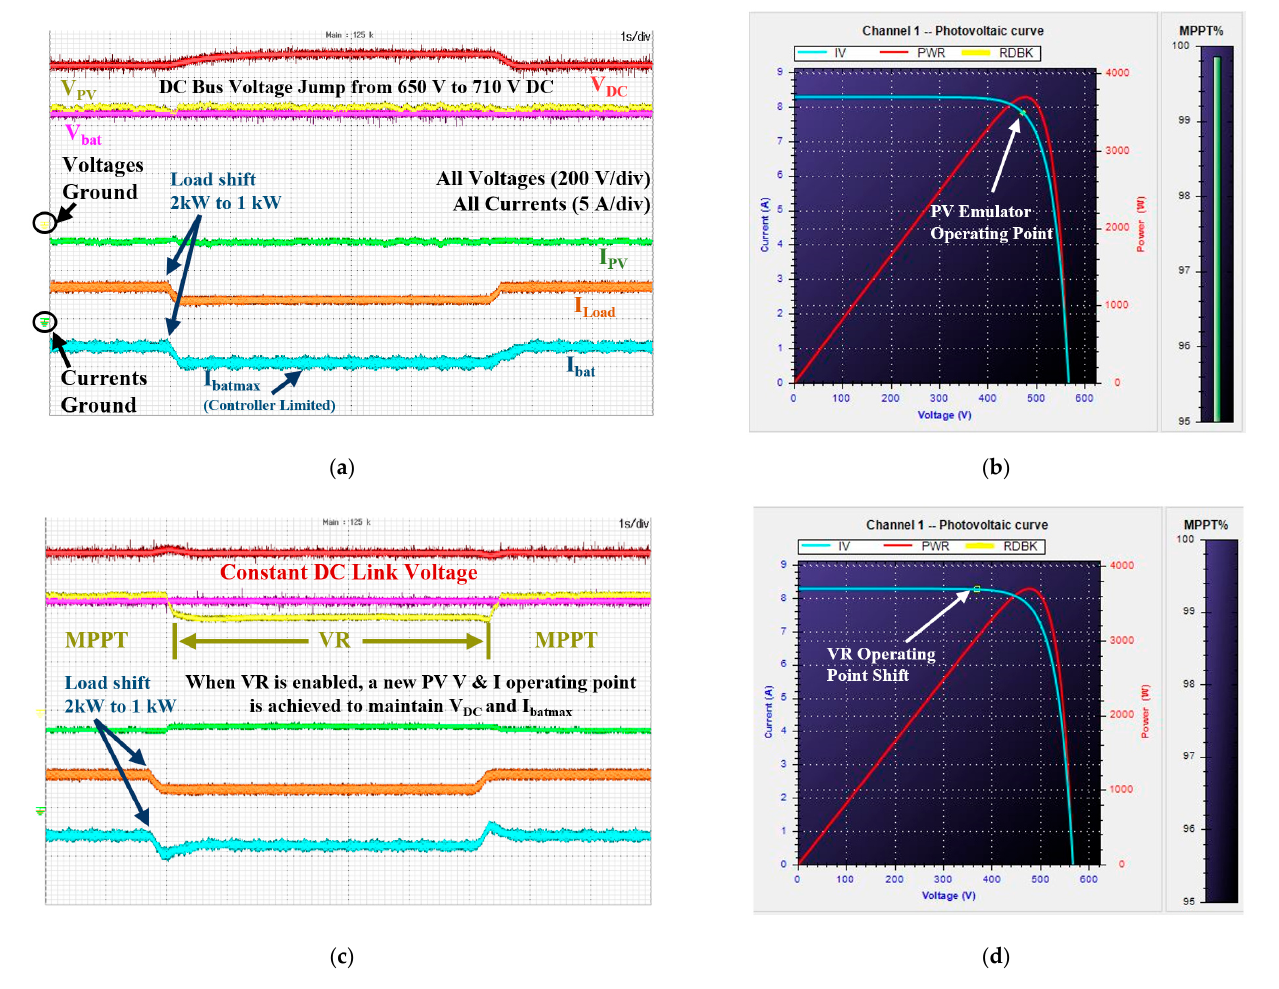
Figure 12. Experimental MPPT–VR–MPPT mode shift validation for the designed EMS: ( a ) excess PV generation without implemented EMS with overvoltage violation, ( b ) MPPT operation of the hardware PV emulator, ( c ) MPPT–VR–MPPT mode shift with the EMS enabled to maintain DC link voltage, ( d ) PV operating point shift of the hardware PV emulator.